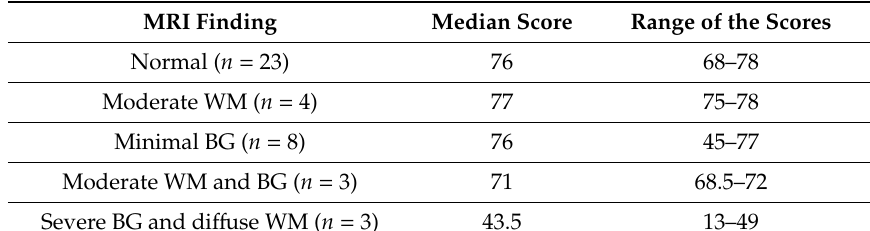
Table 2. HINE scores and neonatal MRI findings.